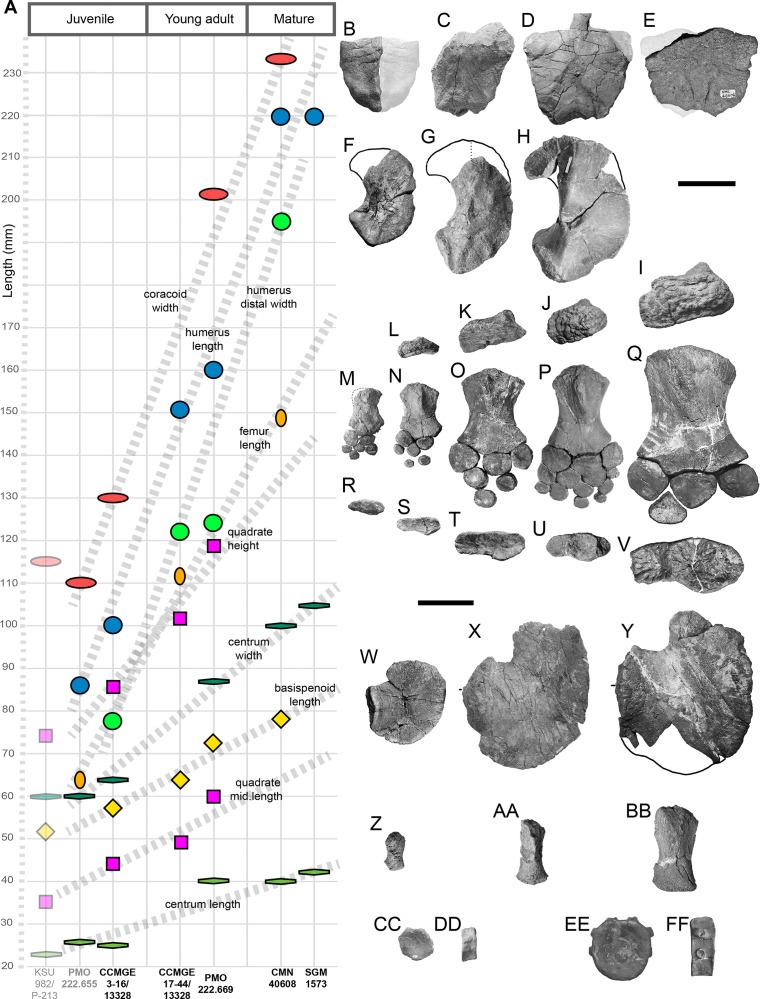
Cranial and postcranial ontogeny of Arthropterygius chrisorum.(A) simplified “plot” showing measurements of various cranial and postcranial elements versus hypothesized ontogenetic stage of the specimen (specimens are arranged equidistantly to each other and divided onto three ontogenetic categories: juveniles, young adults and mature). (B–C) ontogenetic series of selected skeletal elements of A. chrisorum, from top to bottom: basisphenoids in ventral view; quadrates in posteromedial view; humeri in proximal wiew; forelimbs in dorsal view; humeri in distal view; coracoids in ventral view; femora in ventral view; posterior presacral vertebrae in articular and lateral views. Specimens: juvenile of A. chrisorum CCMGE 3–16/13328 (B, F, L, N, S, W, CC, DD); young adults of A. chrisorum CCMGE 17–44/13328 (C, G, K, O, T, AA) and PMO 222.669 (D, H, J, P, U, X); large mature individuals of A. chrisorum CMN 40608 (E, Q, V, Y, BB, EE, FF) and SGM 1573 (I, EE, FF); juvenile of Arthropterygius sp. juv. cf. A. chrisorum PMO 222,655 (M, R, Z); (E, Q, V, Y, BB) are modified from Maxwell (2010). Scale bars for (B–H) equal five cm, for (I–FF) 10 cm.